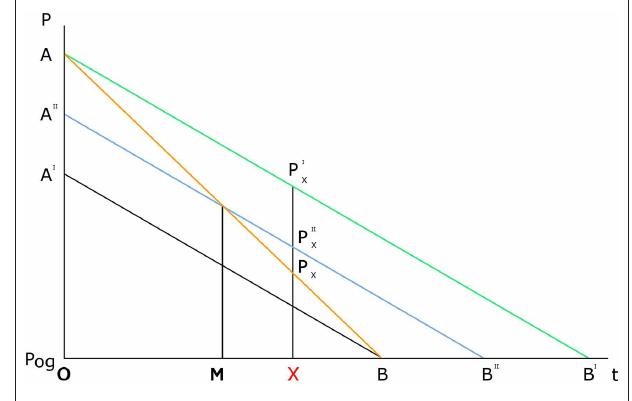
FIGURE 5 | Effect of an improvement of transportation on the price structure: curve AB represents price structure before the transportation improvement, while curve A”B” represents price structure after the improvement. As can be seen while land prices drop closer to the city center due to these improvements, prices beyond OM increase. Thus, for an individual located at X, the price after the transport improvement (P”x) would be greater than before (Px); however, because these improvements lower both the cost and inconvenience of travel, the same (or greater) level of satisfaction is achieved despite the higher price of land, which could be seen as another type of “trade-off”. For the effect of population growth on the price structure: curve A”B” represents price structure before population increase and curve AB’ represents price structure after. NB: location of X does not change but price (P) at that location does (P”x to P’x) ( Alonso, 1964, p. 112, Figure 32 in Location and Land Use: Toward a General Theory of Land Rent Cambridge, Mass.: Harvard University Press, Copyright © 1964 by the President and Fellows of Harvard College. Reproduced with permission).